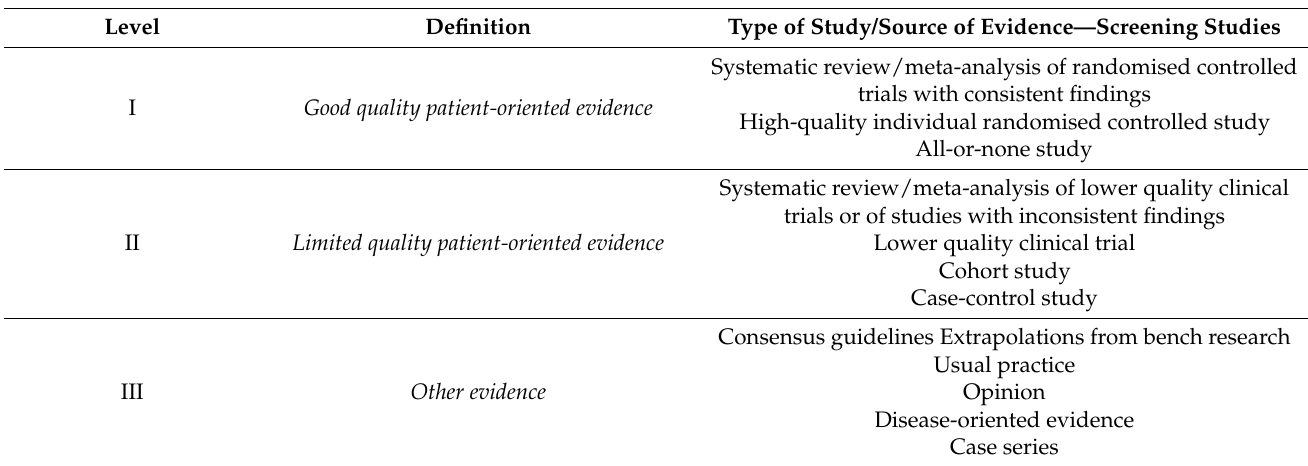
Table A2. The Strength of Recommendation Taxonomy, SORT. Patient-oriented study quality levels of evidence for screening studies, and strengths of recommendations